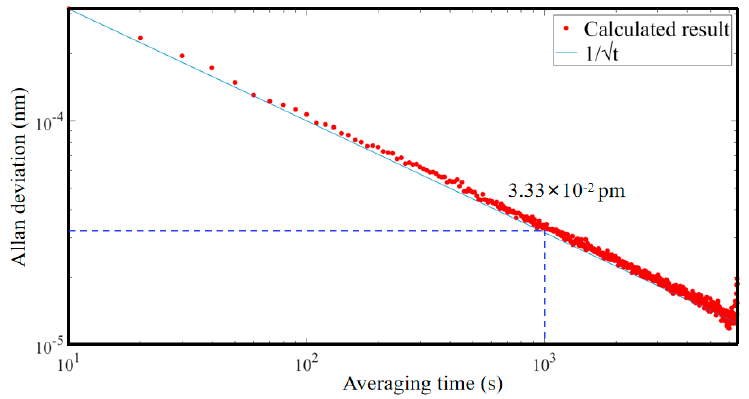
Figure 11. The Allan–Werle analysis results of the pure N 2 gas.